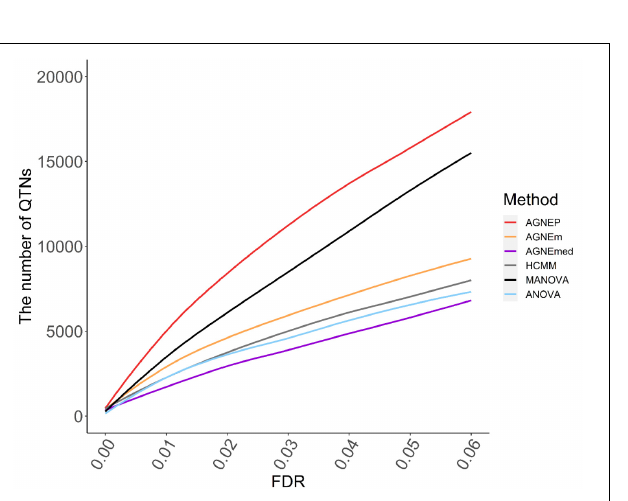
FIGURE 4 | The average computing time (in minutes) of the six methods in three simulations. Scenario 1 (A) and 2 (B) indicate that 10 and 50 QTNs are simulated, respectively.